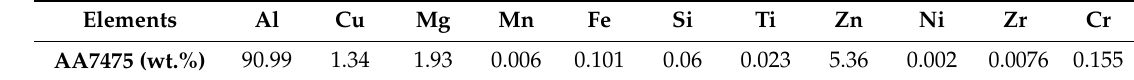
Table 2. Chemical composition of AA7475-T761.